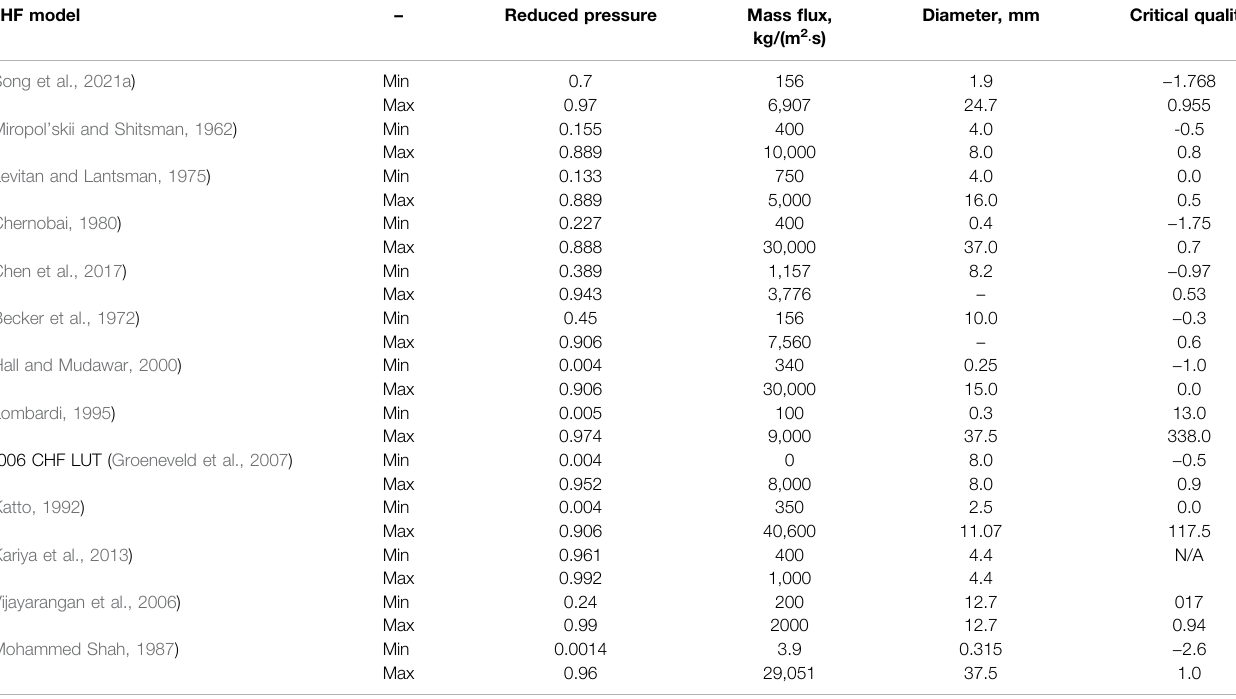
TABLE 3 | Validity range of high-pressure CHF prediction